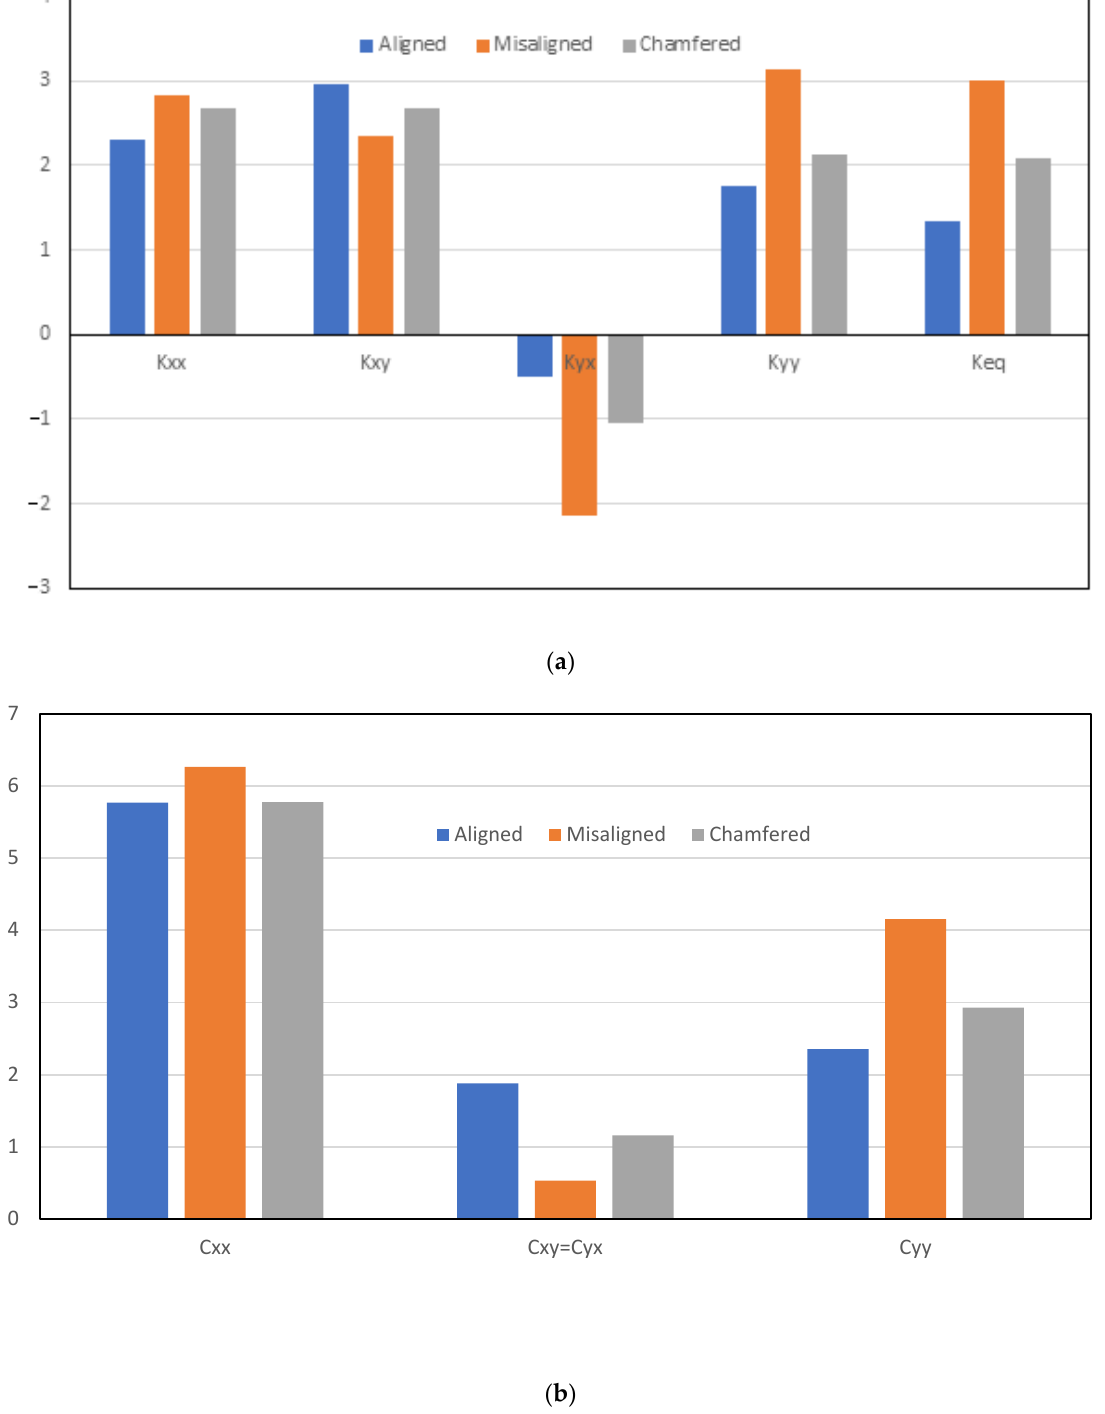
Figure 8. Variation of the dynamic coefficients due to misalignment and the bearing chamfer: ( a ) stiffness coefficients and ( b ) damping coefficients. ( ε r = 0.6, L / D = 1.25, and for the modified and chamfered cases: A = B = 0.25, ∆ h o = ∆ v o = 0.58